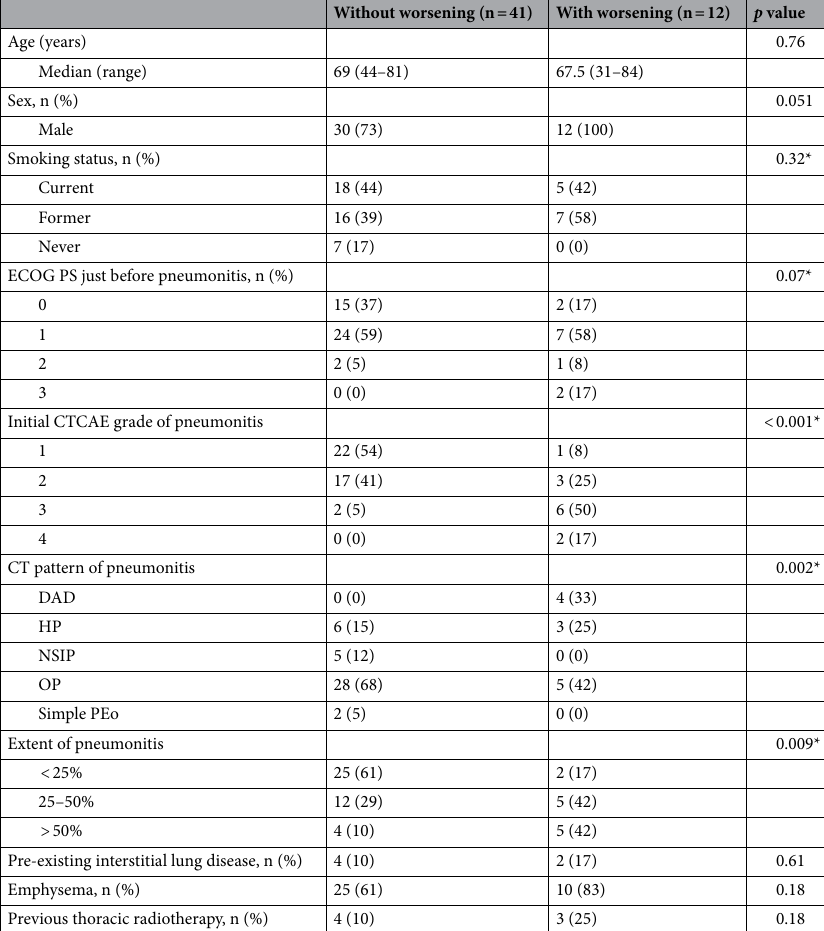
Table 3. Comparison of characteristics at the diagnosis of pneumonitis in patients with and without worsening of respiratory status. Abbreviations: ECOG PS Eastern Cooperative Oncology Group Performance Status, CTCAE Common Terminology Criteria for Adverse Events, CT computed tomography, DAD diffuse alveolar damage, HP hypersensitivity pneumonitis, NSIP nonspecific interstitial pneumonia, OP organizing pneumonia, PEo pulmonary eosinophilia. *Comparison between smokers and never-smokers, performance status (PS) 0–1 and PS 2–3, grades 1–2 and grades 3–4, DAD and others, and ≥ 25% and < 25%.